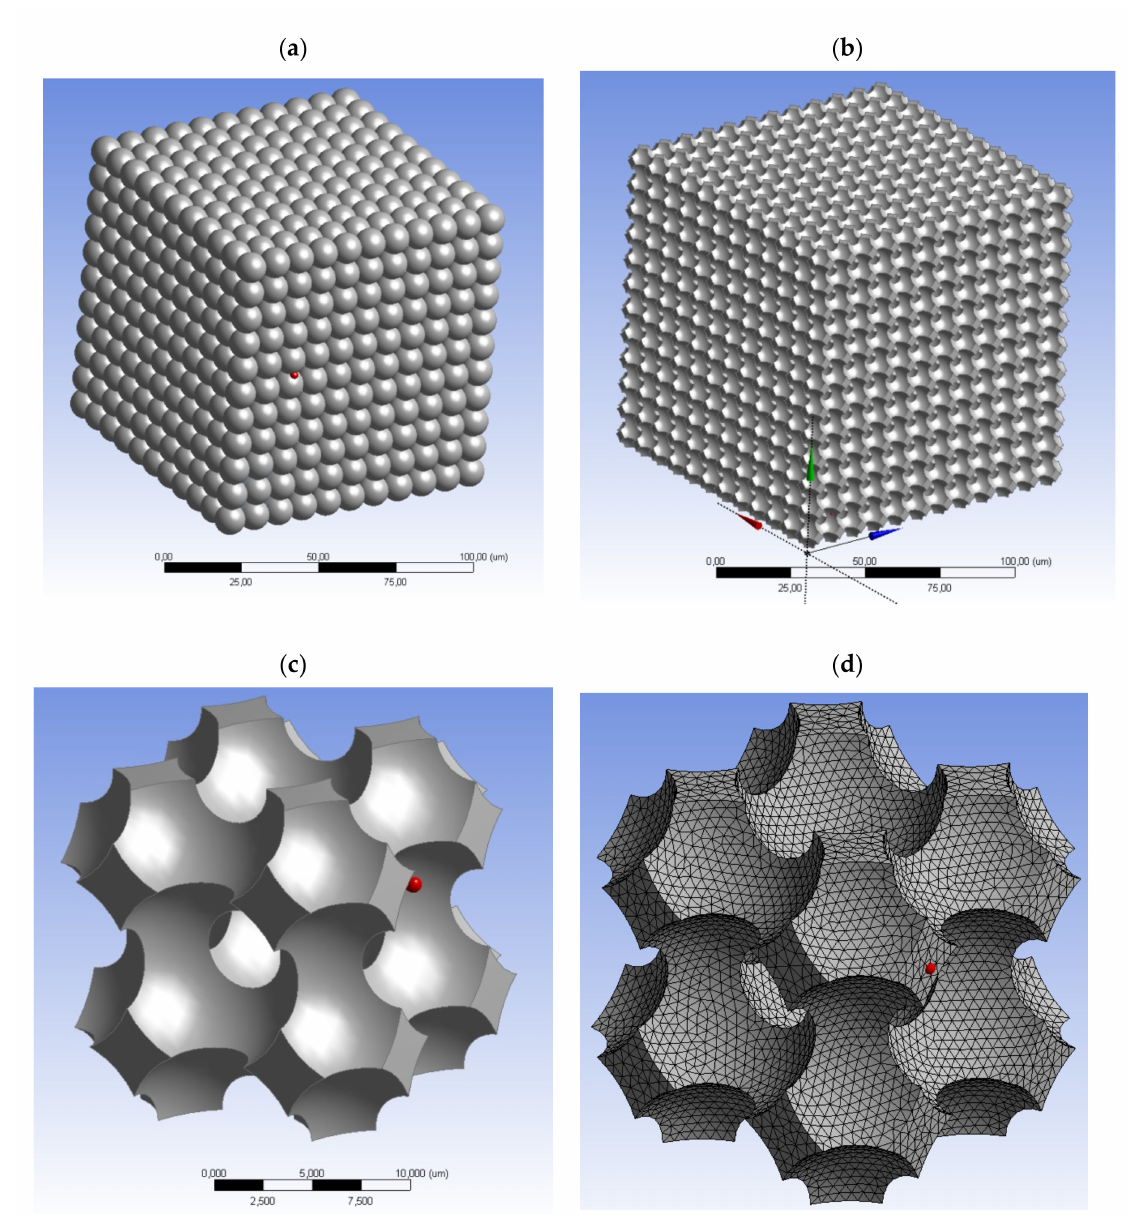
Figure 8. Geometrical model: ( a ) porous bed with a symmetric cube structure a = 20 mm, d k = 10 µ m, Ψ = 32.2%, elementary bed model structure; ( b ) structure of symmetric porous spaces; ( c ) elementary unit of cellular open for flow structure; ( d ) calculation network 85 · 10 3